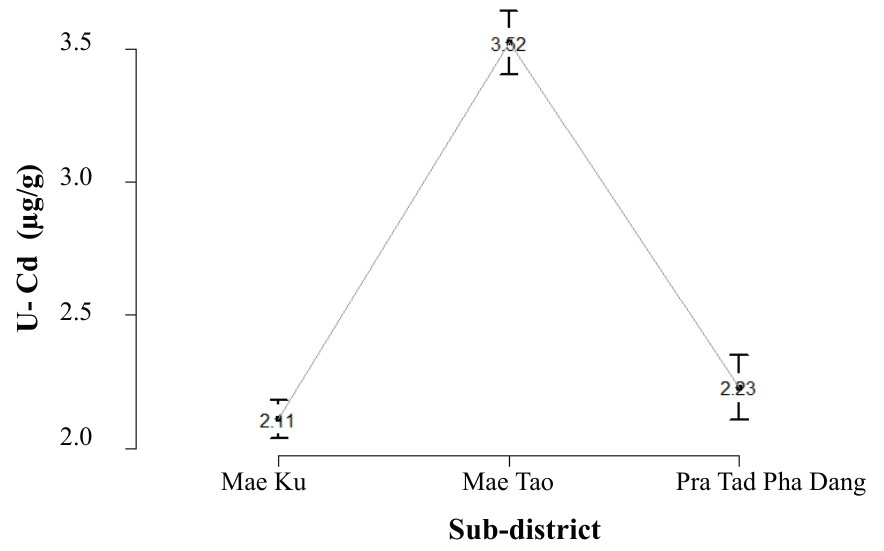
Figure 1. Distribution of urinary cadmium (U-Cd) in the surveyed population in Mae Sot areas: residents in Mae Ku (mean = 2.11 µg/g creatinine, 95% CI = 2.04–2.18), Mae Tao (mean = 3.52 µg/g creatinine, 95% CI = 3.41–3.64), and Pra Tad Pha Dang (mean = 2.23 µg/g creatinine, 95% CI = 2.11–2.35).